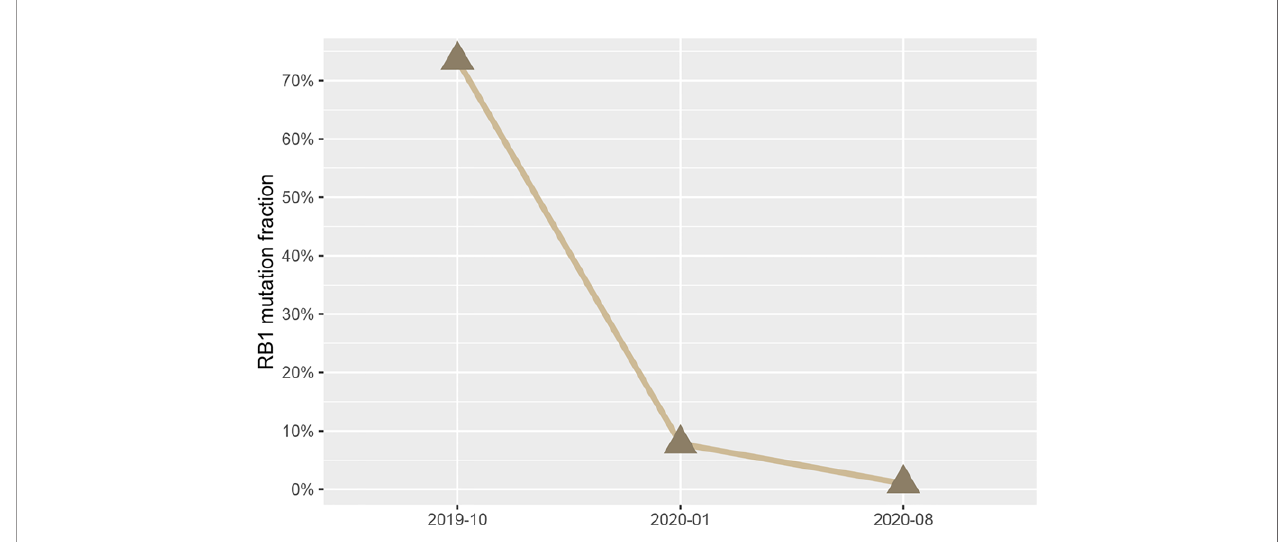
FIGURE 2 | The mutation frequency of the RB1 gene in the urine of the